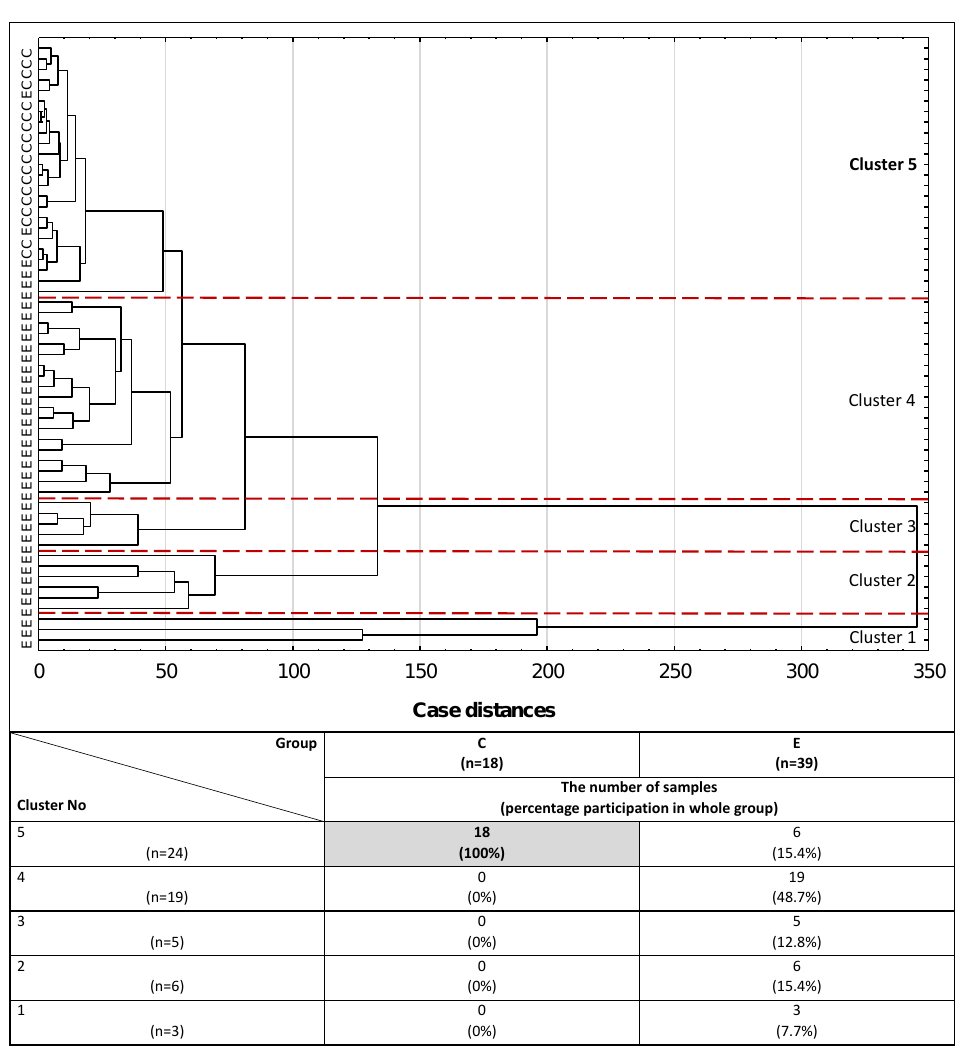
Figure 3. Dendrogram of cluster analysis of serum IL-6, PRL and CA 125 expression for endometriosis and control groups. E—endometriosis, C—control group. The cluster analysis was performed only for parameters with the highest AUC value and for serum samples in which the concentrations of all three parameters were determined. Each serum sample is represented by a vector of three features: IL-6, PRL and CA 125. Cluster 5 and a cut-off lane separate 100% of women from the control group and 15.4% of endometriosis patients from the rest of the endometriosis samples (Clusters 1– 4).